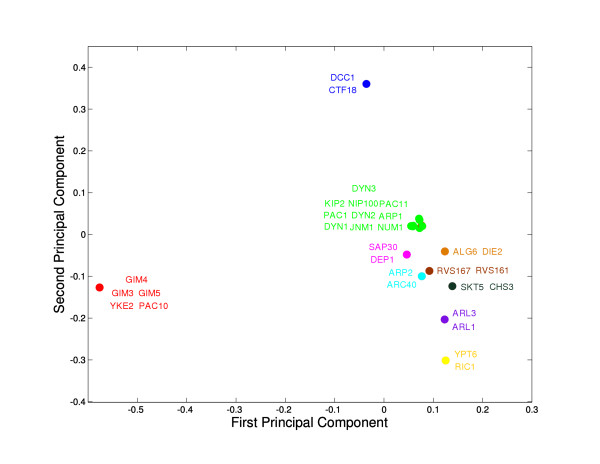
Two-dimensional embedding of Type 1 network motifs. Each motif is represented by two leading principal components generated by multidimensional scaling based on a Euclidean distance matrix. Colors indicate connected components from the Type 1 network.